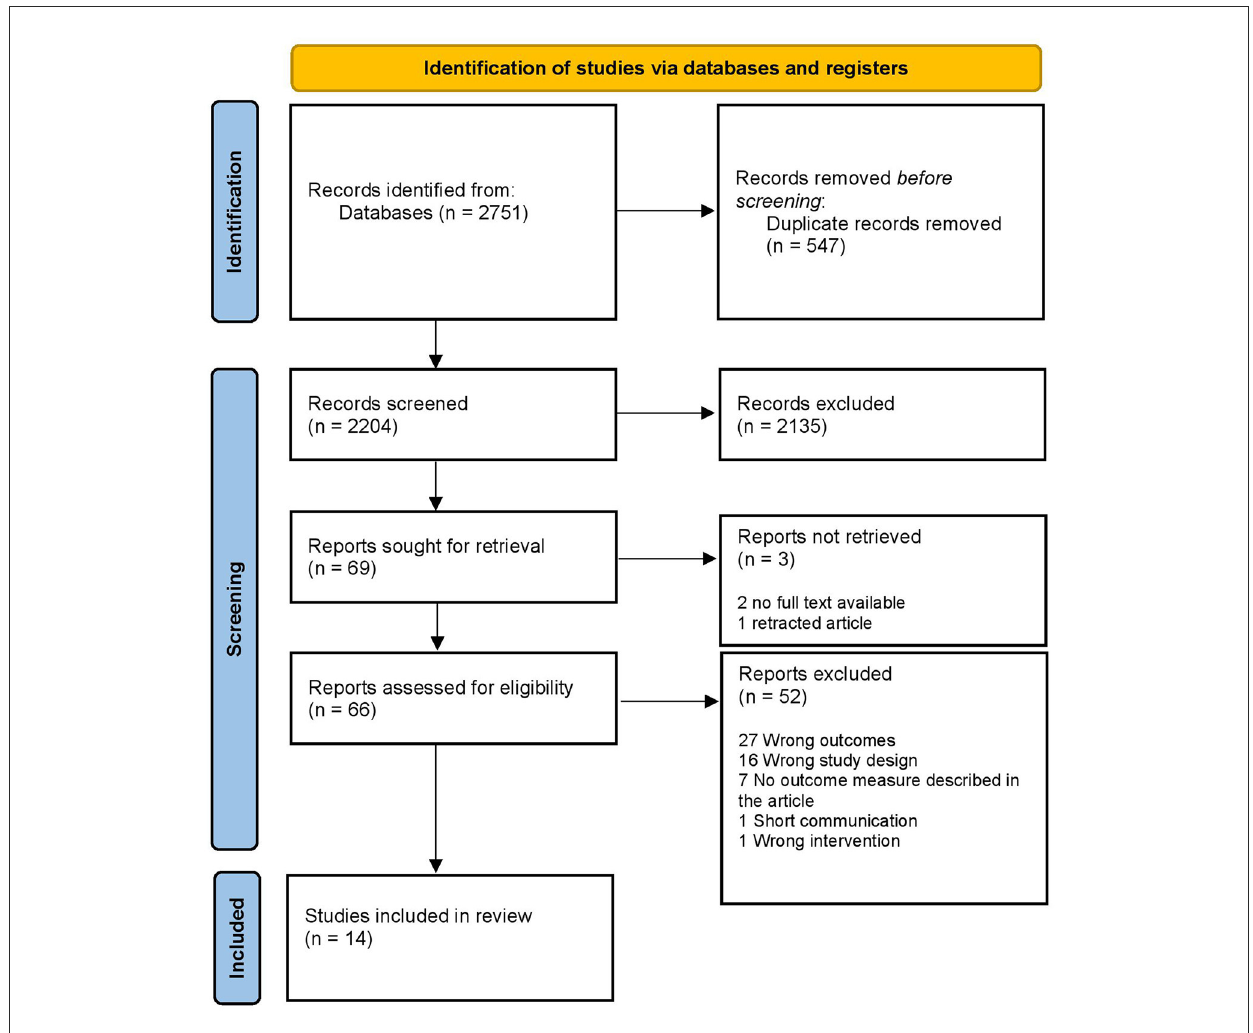
FIGURE1 Flow diagram of the search